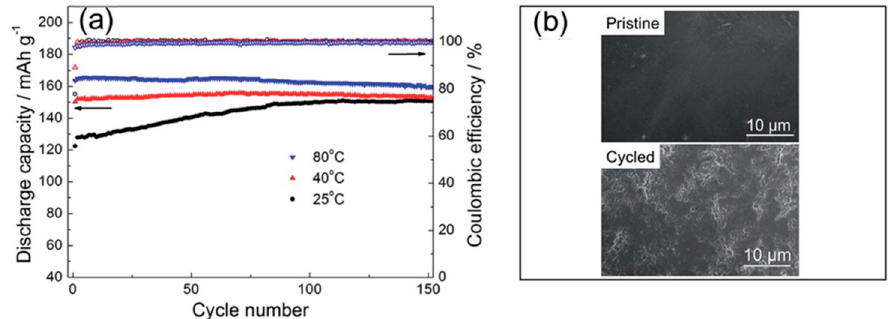
Figure 1. The performance of Li|SPE: 50:20:50 P(DADMA)-TFSI:LiTFSI: C 2 mpyrFSI|LiFePO 4 cells: ( a ) discharge capacity and coulombic efficiency versus cycle number at 25 °C, 40 °C and 80 °C at a current rate of 0.2 C, ( b ) SEM images of the pristine lithium and lithium anodes after a rate test (0.2 C, 0.5 C, 1 C and 0.2 C). Adapted from Li et al. [140] with permission from The Royal Society of Chemistry.